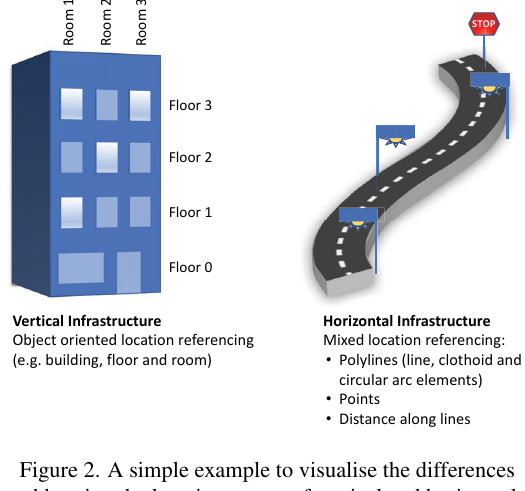
Figure 2. A simple example to visualise the differences addressing the location aspect of vertical and horizontal infrastructure (Kenley and Sepp¨anen, 2009; McCrae and Singh, 2009). Figure 3. The principle of road asset location referencing using points, polylines, and polygons (Consultants,